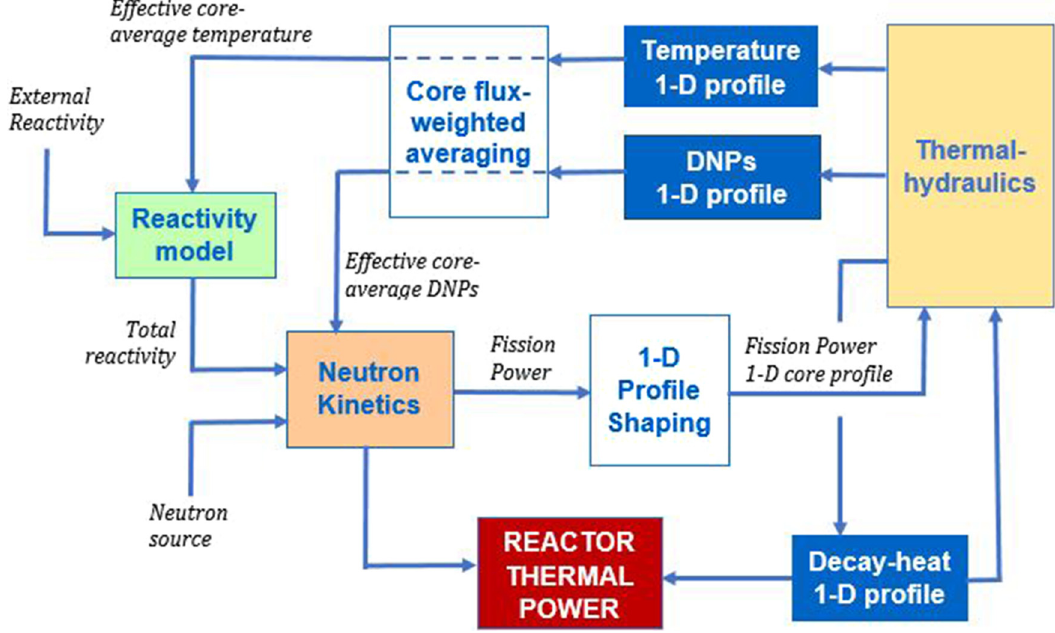
Fig. 4. Conceptual scheme adopted for the MSFR